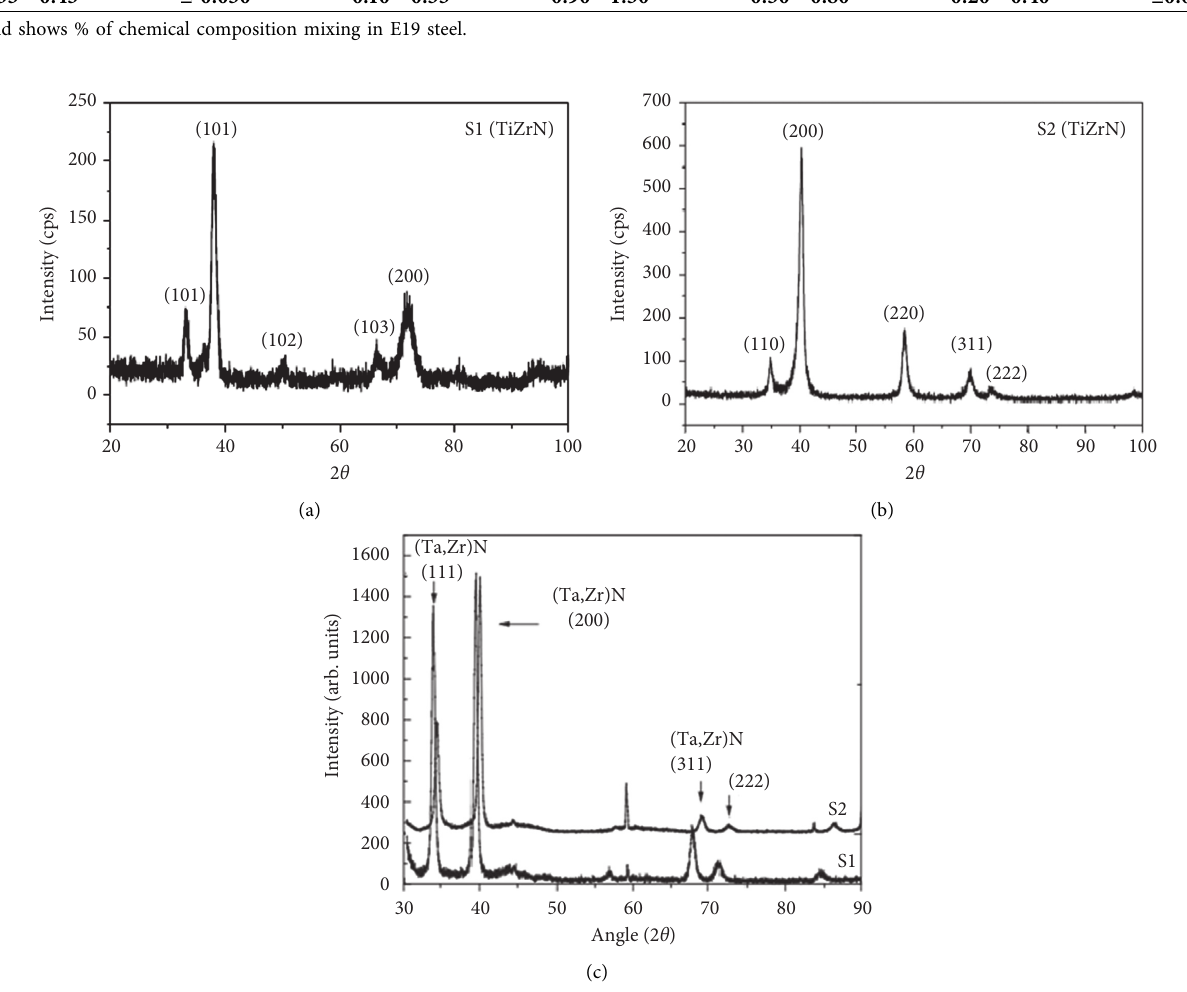
Figure 1: X-ray diffraction patterns of TiZrN/TaZrN films with different temperature contents. Table 3: Surface roughness and hardness of coated material.